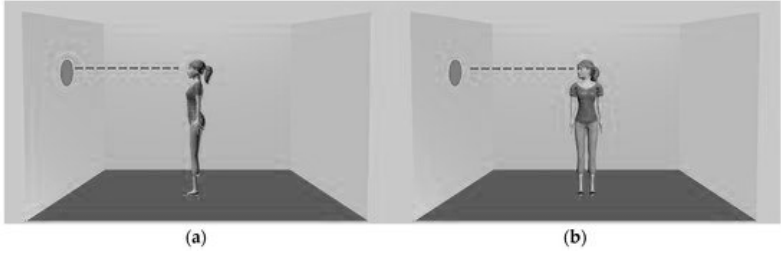
Figure 8. Gaze-maintained and gaze-averted avatars used by Gardner et al. [34].